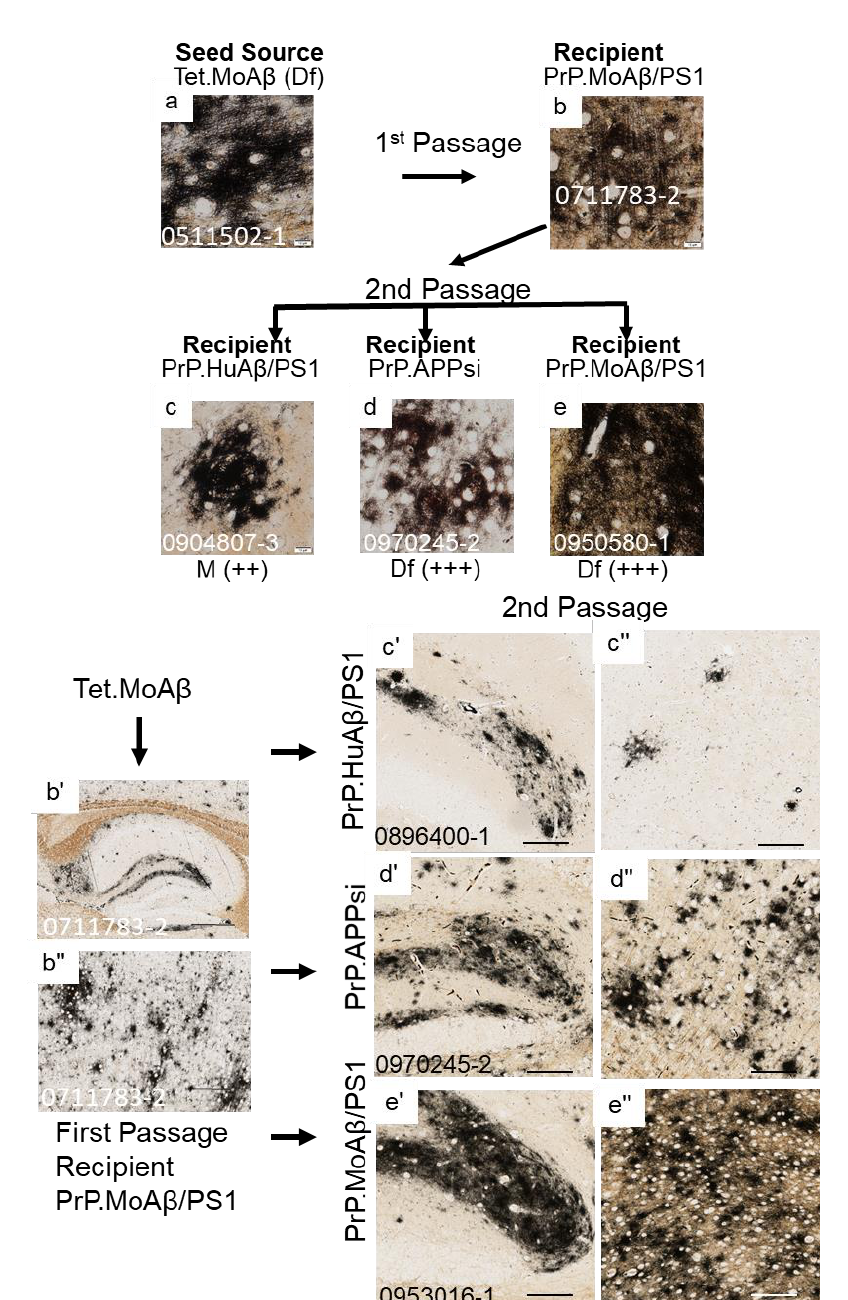
Figure 3. Serial passage of diffuse A β pathology through a PrP.MoA β /PS1 host. The upper panels show high-power images of A β deposit morphology from C-S silver staining in the brain of the seed source animal, the brain of the first passage recipients, and the brains of the second passage recipients. A β pathology was confirmed by A β immunostaining (Figure S3). The criteria for scoring pathology burden were the same as described in the legend of Figure 1. The lower panels show low-power views of the seeded animals. Details of animal numbers for each injection are provided in Tables 3 and S2. ( a ) Image from the cortex of the original seed source Tet.MoA β animal [26]. ( b , b’ , b” ) Images from the recipient PrP.MoA β /PS1 mouse used as host for Passage 1 (aged 12 months before harvest). ( c , c’ , c” – e , e’ , e” ). Representative images of brains from recipients seeded with first passage brain from PrP.MoA β /PS1 mice ( b , b’ , b” ). In the upper panel, below each row of images from the secondpassage seeded animals, information is provided on pathological rating (Df = diffuse; Cr = cored) and relative severity, using the same scoring system as in Figure 1. ( a – e ) Images of cortex. ( bʹ – eʹ ) Images of hippocampus. ( bʹʹ – eʹʹ ) Images of cortex. The scale bars are as shown in the legend of Figure 2.